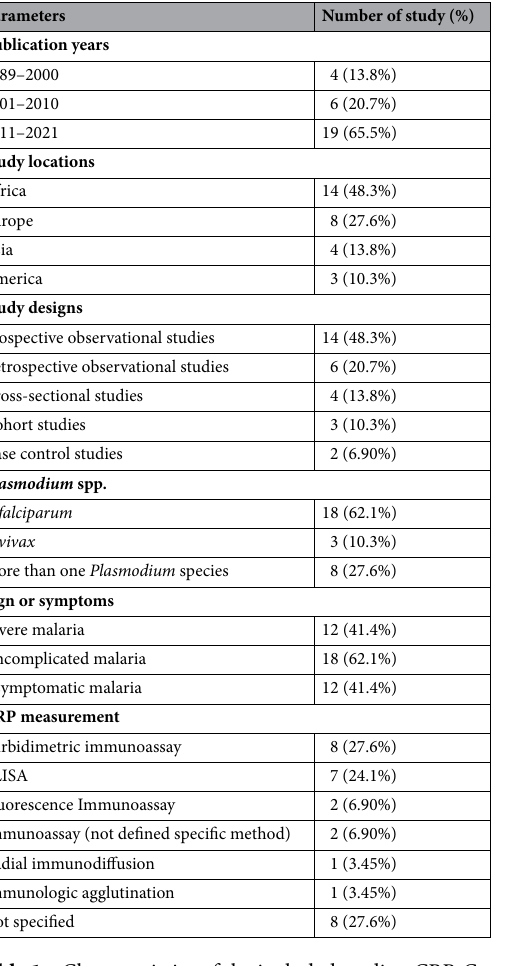
with uncomplicated malaria and febrile/healthy controls, and (4) patients with asymptomatic malaria and febrile/healthy controls. Data synthesis. In the meta-analysis, the mean and standard deviation (SD) of CRP between two groups were used to estimate the pooled standard mean difference (SMD) and 95% confidence interval (CI). The SMD and 95% CI of each outcome were estimated using the random-effects models provided in the STATA Statistical from the median and range as described previously 24 . Additionally, if the included studies reported separate mean and SD for the clinical symptoms of malaria including CRP in cerebral and severe anemia, the mean and SD were combined as a single “severe malaria” as described previously 25 . The heterogeneity among the included studies was assessed using the Cochrane Q and I 2 statistics. Cochrane Q statistic with a p-value of less than 0.05 indicated a significant heterogeneity among the included studies, while I 2 statistics of more than 50% indicated a substantial heterogeneity among the included studies. When heterogeneity was significant or substantial, the random-effects model was applied to the pooled analysis. Conversely, the fixed-effects model was applied to the pooled analysis if nonsignificant heterogeneity was demonstrated. Meta-regression analysis was performed to assess potentially important covariates that might have a substantial impact on the heterogeneity. These covari- ates included the mean age of participants, male percentage, continents (Asia, Africa, America, Europe), types of infection ( Plasmodium spp.), and types of control (febrile or healthy controls). Then, subgroup analyses were conducted for these covariates. A sensitivity test was performed to assess (1) the pooled SMD after excluding studies that reported the median CRP, (2) the pooled SMD after excluding studies with six stars’ quality, and (3) the pooled SMD using a fixed-effects model compared with the random-effects model. The publication bias among the included studies was assessed by visualization of the funnel plot and Egger’s test for asymmetry. If the Egger’s test showed asymmetry, the contour-enhanced funnel plot was further assessed to determine whether the asymmetry was due to publication bias or other factors.